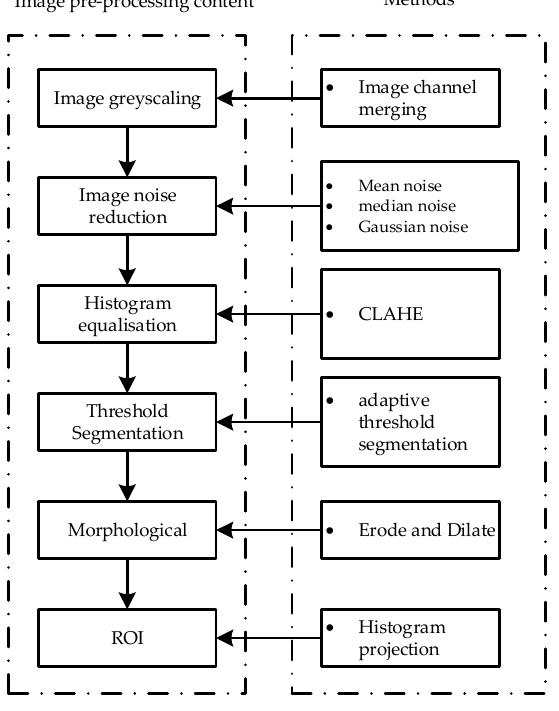
Figure 5. Preprocessing steps for the original images.